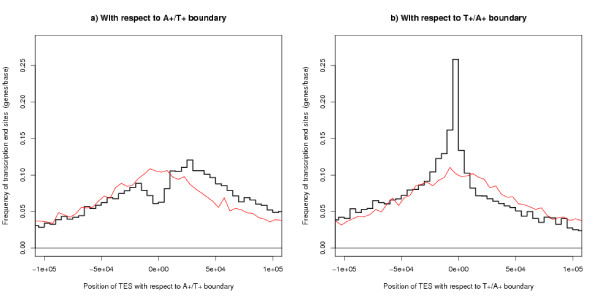
Position of TES with respect to the segment boundaries. The bold black line shows results for real TESs and the faint red line is a control plot for randomly chosen positions. (a) shows the A+/T+ boundary and (b) shows the T+/A+ boundary.